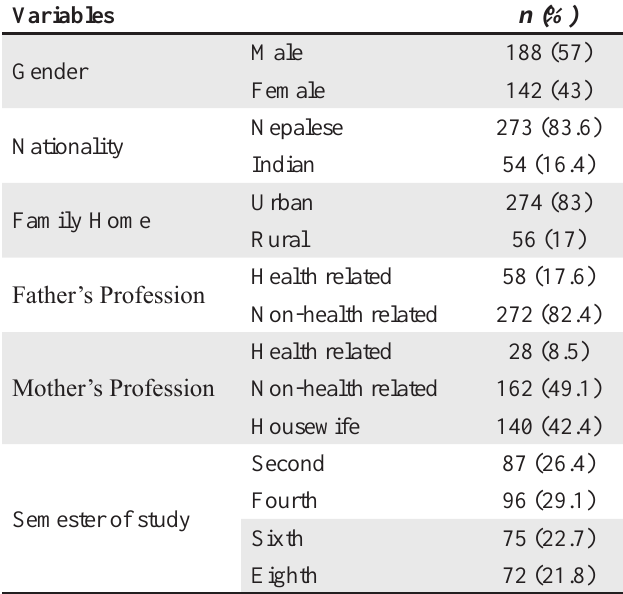
Table 1 : Demographic profile of the respondents (N = 330) Variables